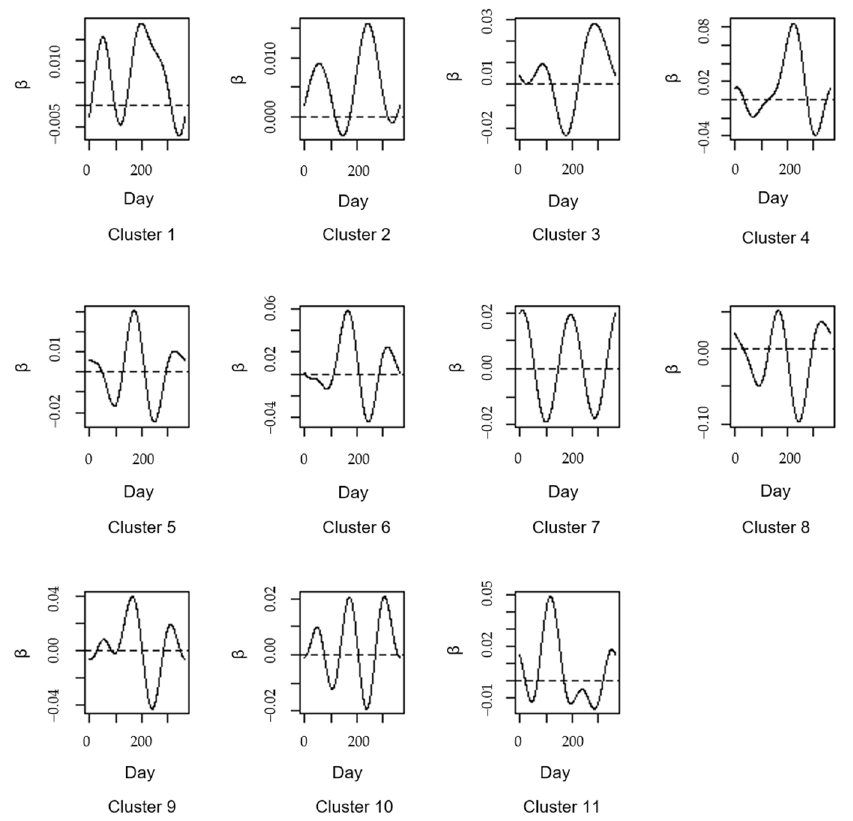
Figure 6. Parameter estimation of the different partitions given by the FCR-HL models.